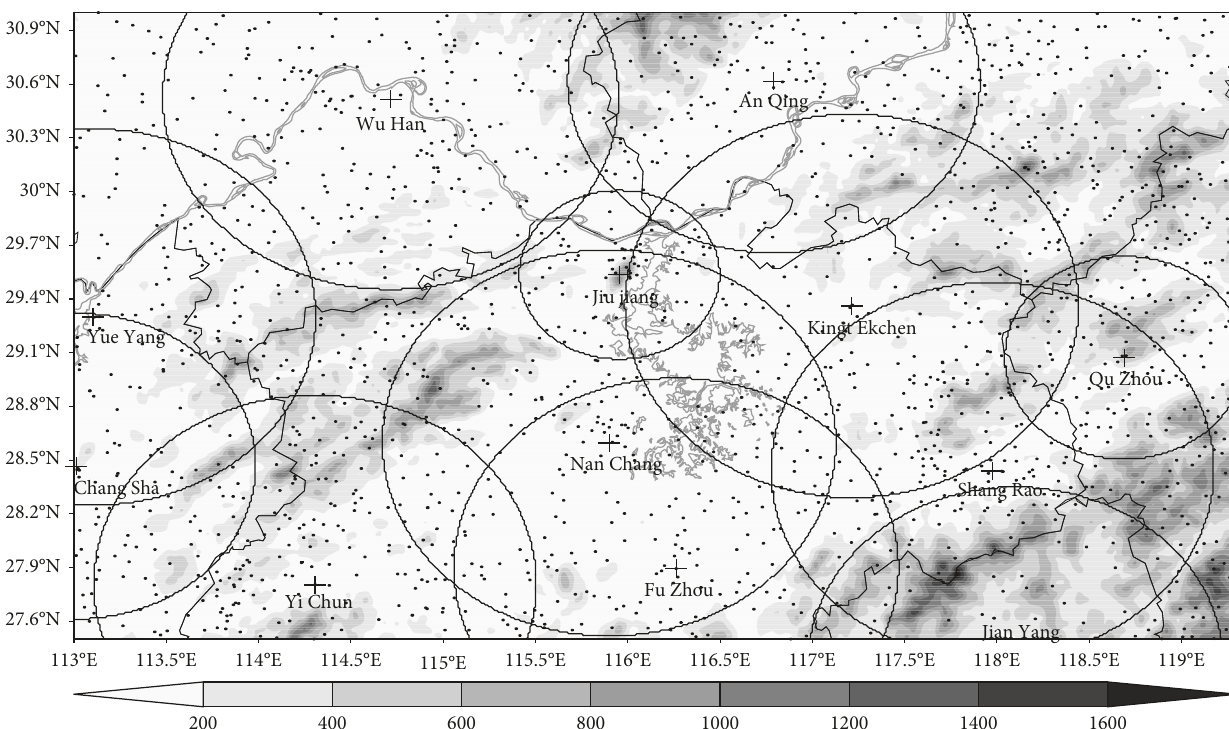
Figure 1: Doppler radar stations (cross point) and automatic rainfall observation stations (dot) over the middle and lower reaches of Yangtze River. Circles indicate the range of CAPPI at 2 km height and shaded portions indicate altitude (unit: